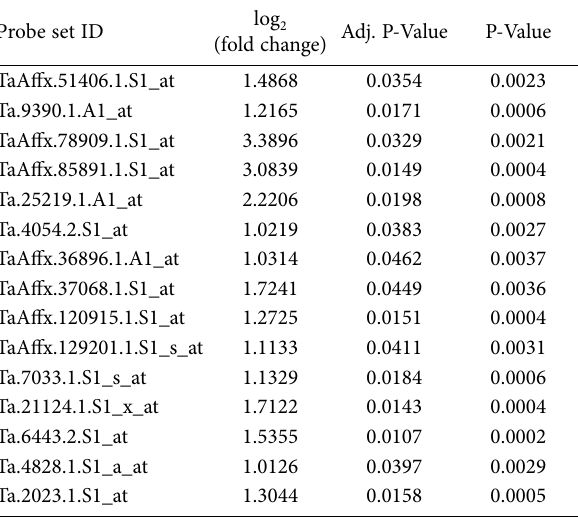
Table 2. Top 15 exclusively upregulated genes in the resistant geno- type 12